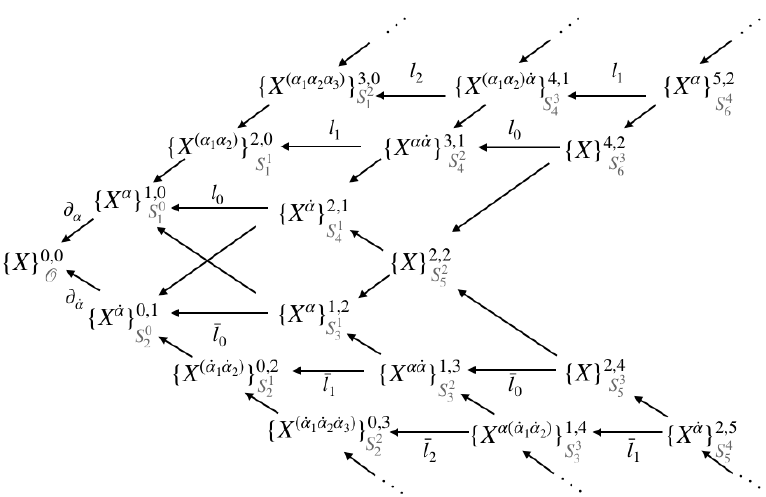
Figure 2. This is the tree diagram to illustrate how corrections work. Arrows point from the correction spaces to the spaces they correct. Maps above the arrows represent the maps: ∂ α , ∂ ˙ α for the zeroth order maps, and l n , ¯ l n for higher orders. See the text for the explicit form of l n , ¯ l n